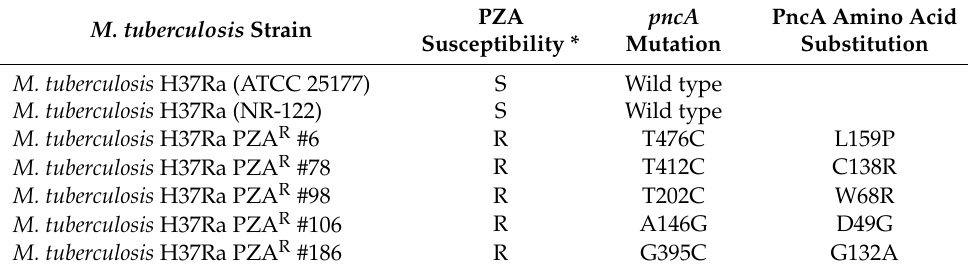
Table 4. Descriptions of the tested